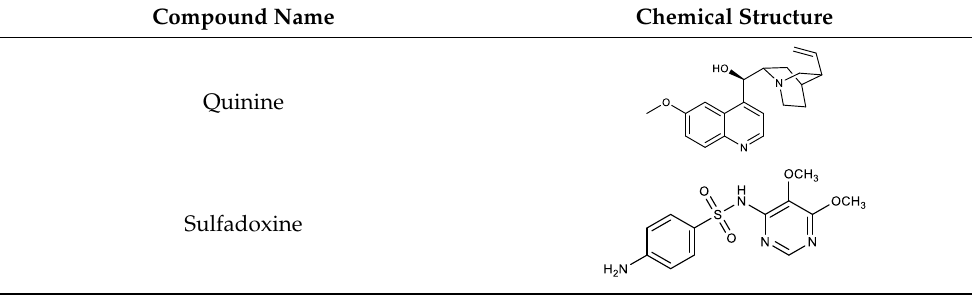
Table 1. Structures of the selected conventional drugs for the developed method.